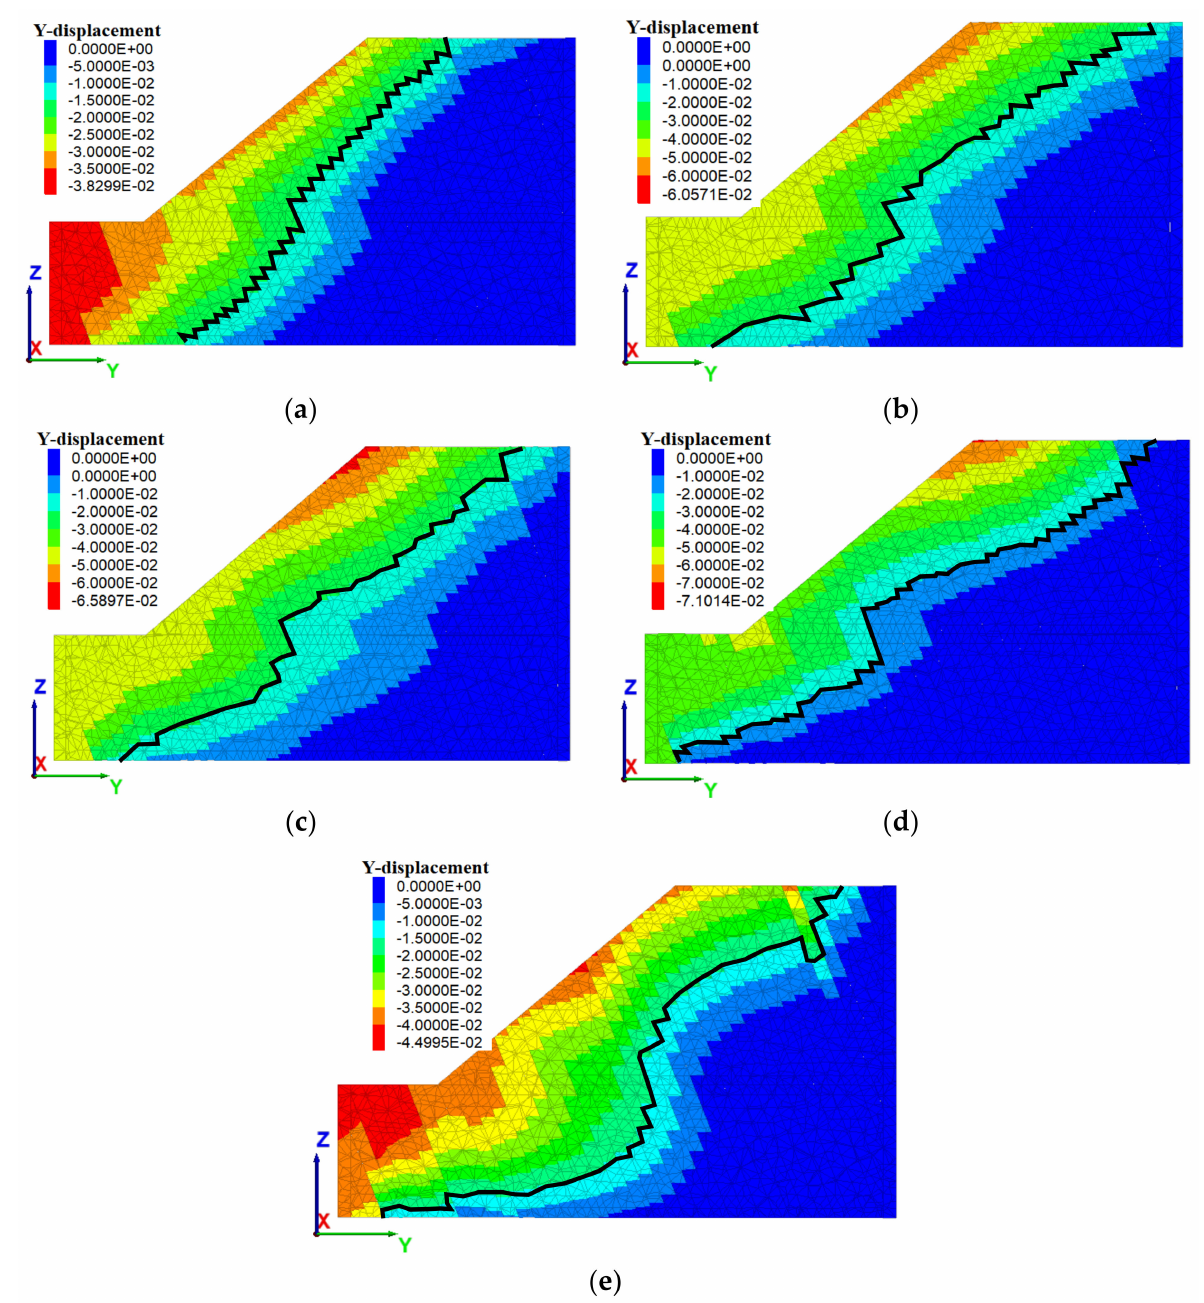
Figure 12. Contour plots of the displacement in the Y -direction of a slope ( α = 40 ◦ and β = 70 ◦ ) subjected to a sinusoidal wave. The plots show the displacements in the plane corresponding to x = 10 m at the end of the period of disturbance ( t = 5 s) for different values of γ : ( a ) 0 ◦ , ( b ) 5 ◦ , ( c ) 10 ◦ , ( d ) 15 ◦ , and ( e ) 20 ◦